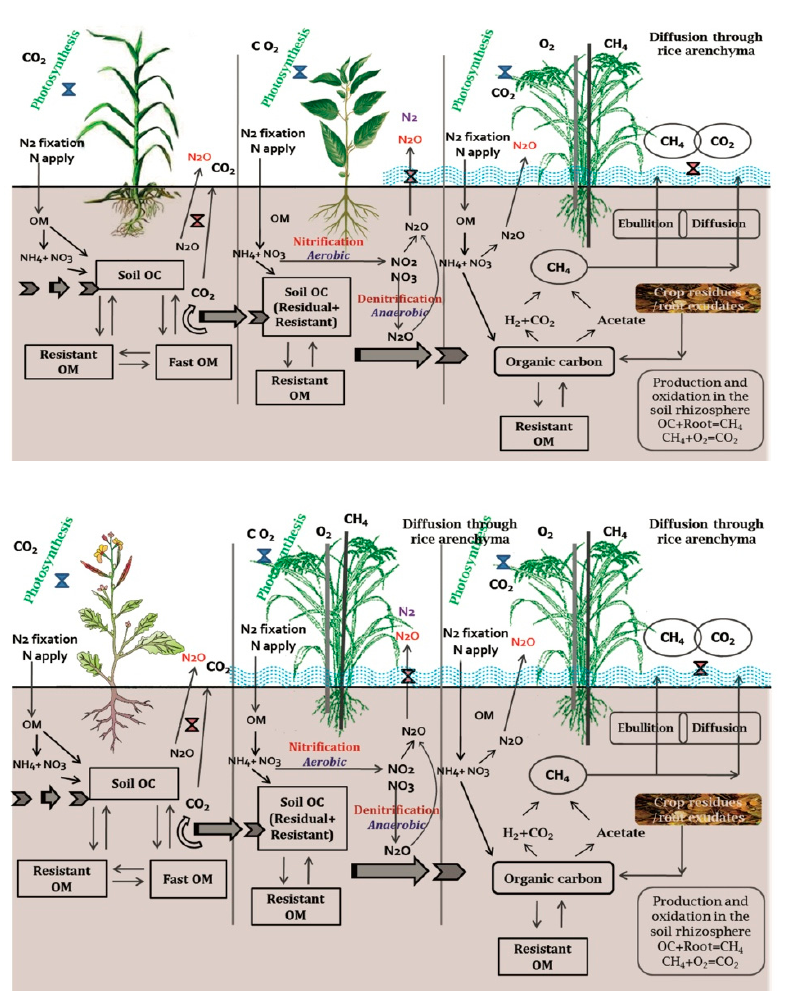
Figure 1. Conceptual diagram of C cycle of rice-based, triple cropping systems Source: Alam [53].